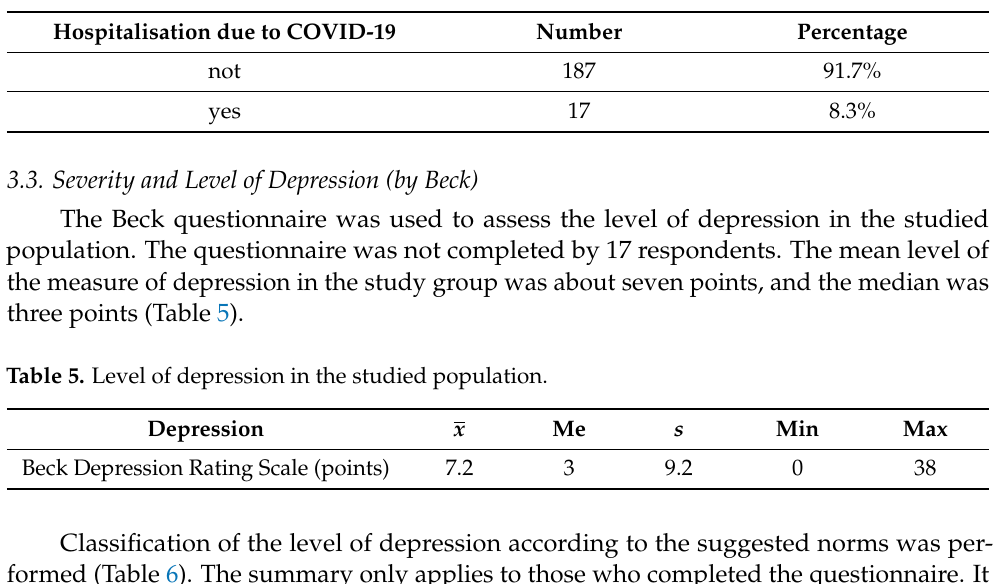
Table 4. Hospitalisation due to COVID-19.